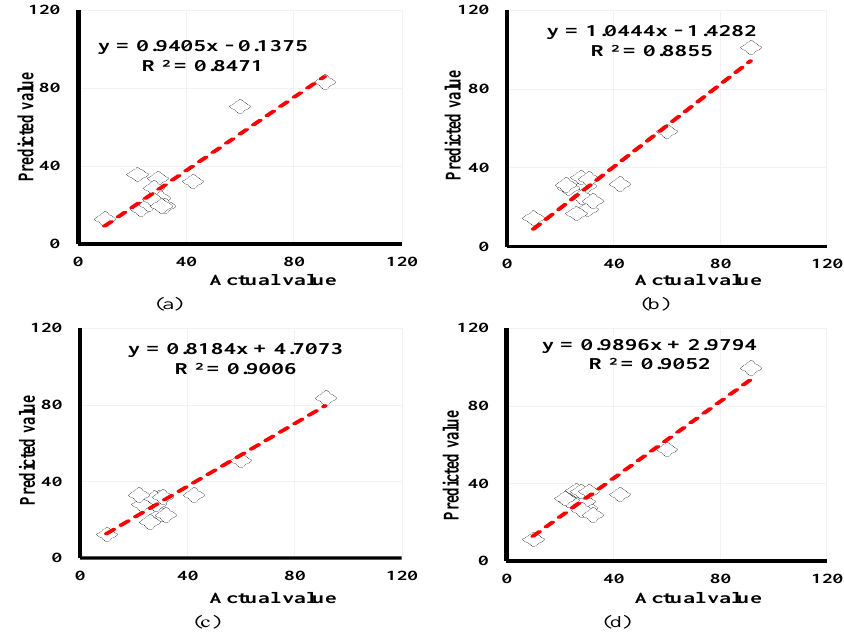
Figure 7. Correlation charts for the testing results of ( a ) HHO – ANFIS, ( b ) SSO – ANFIS, ( c ) TLBO – ANFIS, and ( d ) WCA – ANFIS.